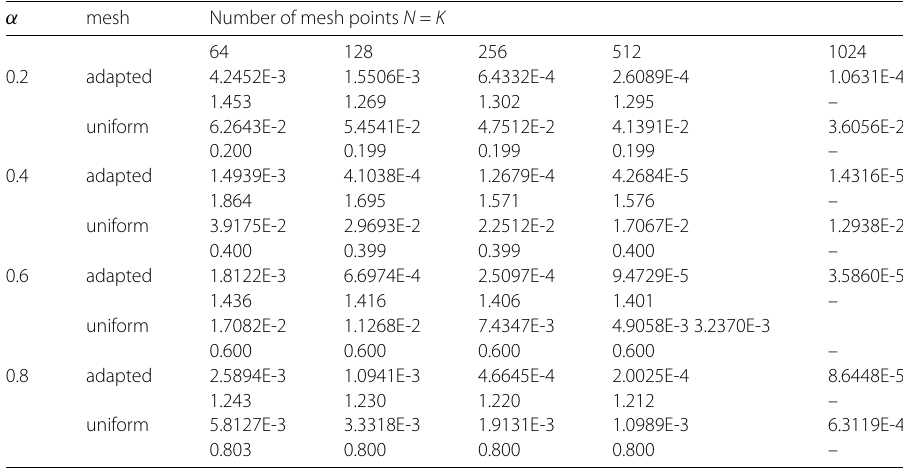
Table 1 Error estimates and convergence rates for Example